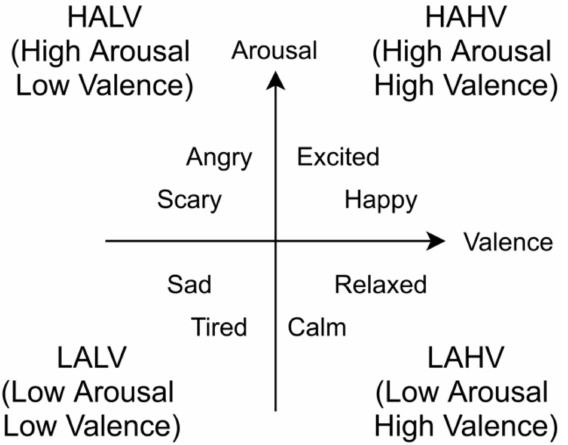
Figure 1. Arousal–Valence space